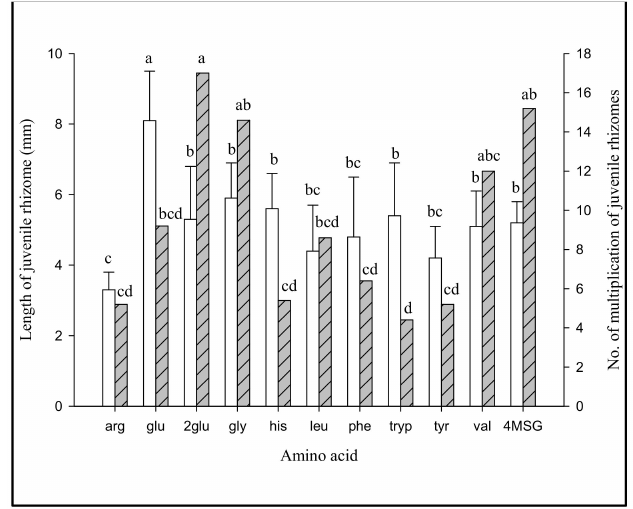
Figure 6. Effect of amino acid on growth and proliferation of G. elata juvenile rhizomes after 8 weeks in YH2 culture medium. Each value is expressed as mean ± SD (n = 5). Means followed by the different letter(s) are significantly different at p < 0.05 by Fisher’s protected LSD test. a,b,c,d Mean values with unlike letters were significantly different. Basal medium YH2: YH1 + 3.5 g/L gelrite (to replace 8 g/L agar) arg: 1 g/L arginine; glu: 1 g/L glutamic acid; 2glu: 2 g/L glutamic acid; gly: 1 g/L glycine; his: 1 g/L histidine; leu: 1 g/L leucine; phe: 1 g/L phenylalanine; tryp: 1 g/L tryptophan; tyr: 1 g/L tyrosine; val: 1 g/L valine; 4MSG: 4 g/L monosodium glutamate (Na-glutamate).